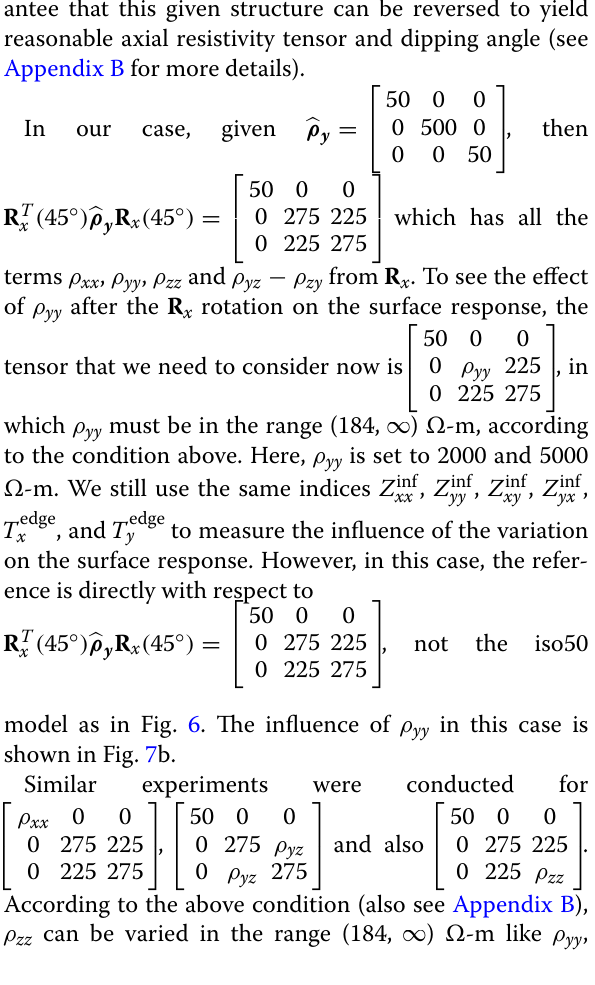
Fig. 6 a Logarithmic plots of Z inf xx , Z inf yy , Z inf xy , and Z inf yx and b T edge x ,